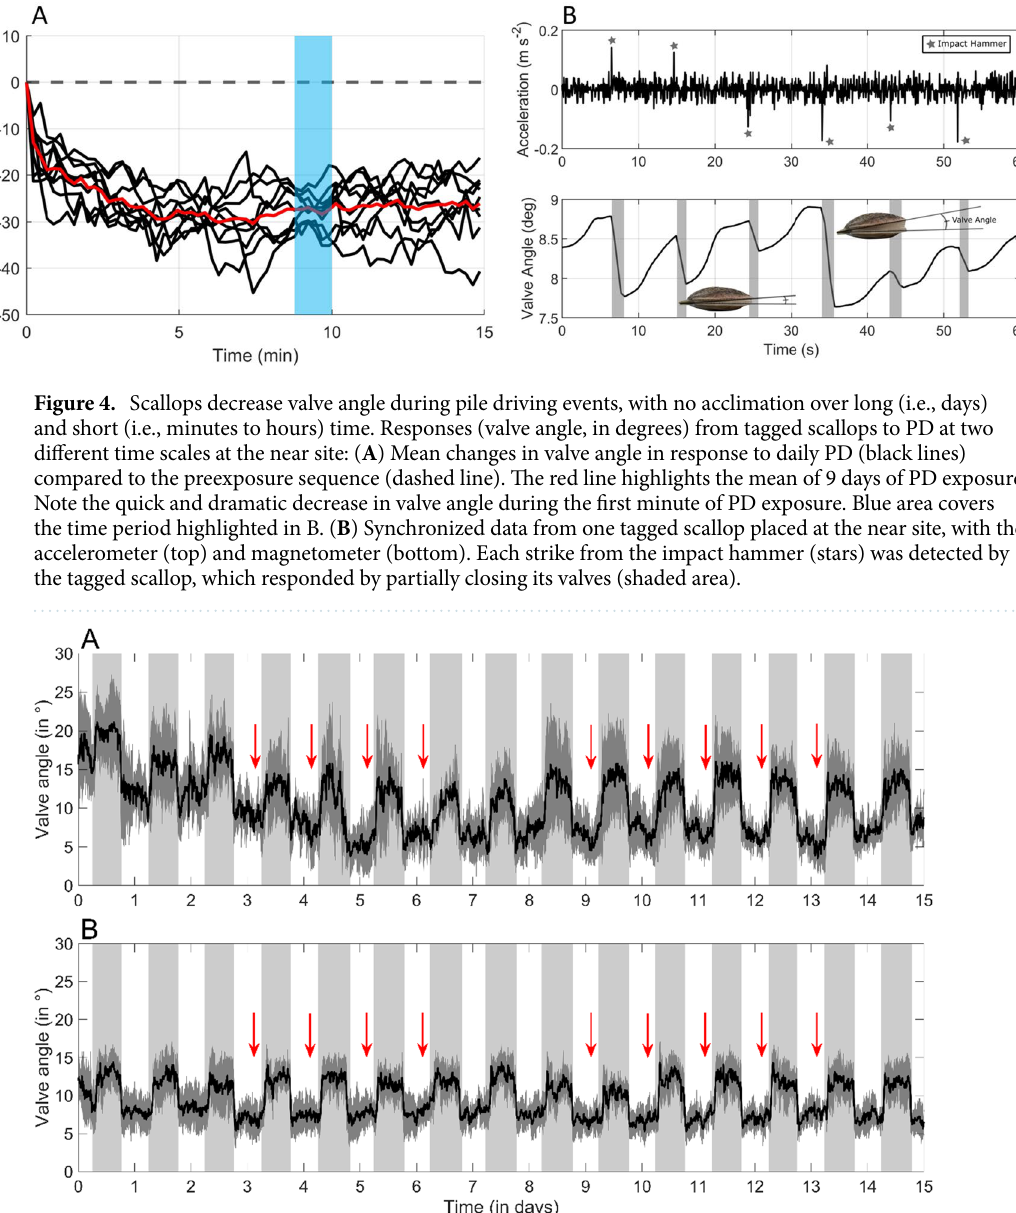
Figure 5. Scallop diurnal rhythm, with higher valve angles during the night, may render these bivalves more sensitive to night-time pile driving events. Valve angles (in degrees) from tagged subadult scallops ( n = 10) recorded at the two experimental sites ( A : near site; B : far site) across two weeks of PD exposures, represented as means (bold black lines) and standard deviations (dark gray). White and shaded areas indicate daytime and nighttime periods (respectively) over the 15-d monitoring period (11–26th September 2021). Red vertical arrows highlight the time when daily PD